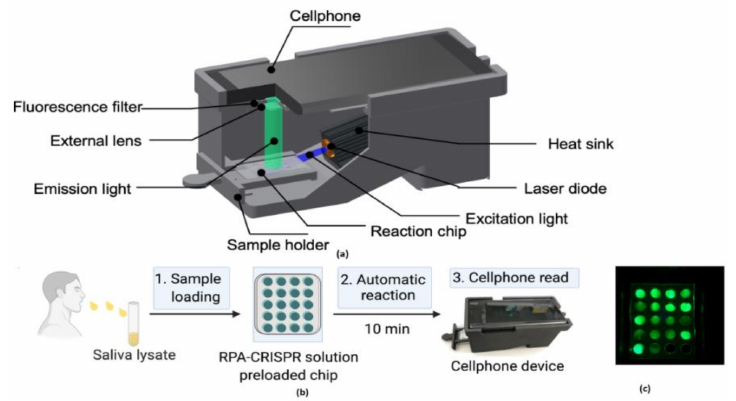
Figure 36. ( a ) The 3D-printed schematic of smartphone fluorescence reader ( b ) Saliva-based CRISPR Fluorescence Detection System (FDS) Assay procedure. ( c ) Capture images of CRISPR-FDS Assay [41].